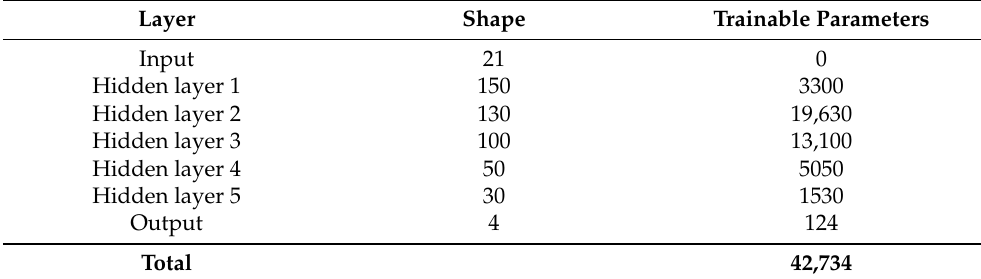
Table 9. The number of trainable parameters of the proposed SRMT model [11]. Layer